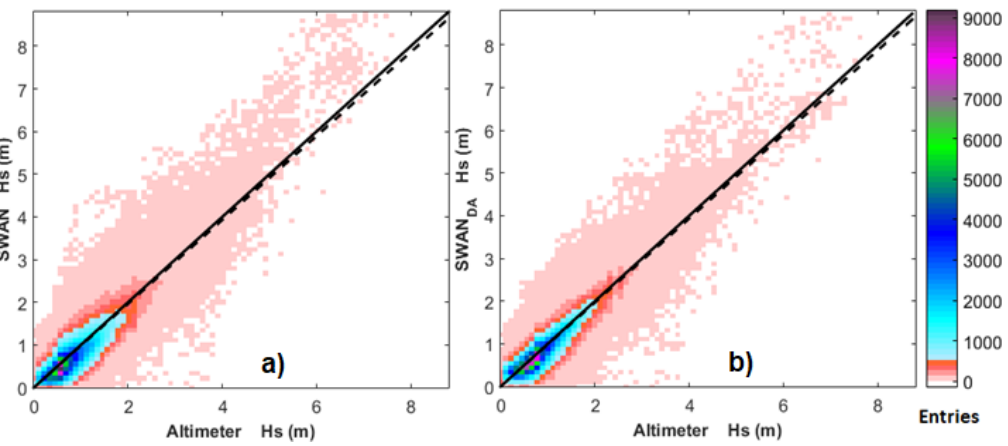
Figure 3. Hs s catter diagrams: a ) SWAN without DA and b ) SWAN with DA ( right ), results Figure 3. Hs scatter diagrams: a ) SWAN without DA and b ) SWAN with DA ( right ), results corresponding to the 15-year time interval 1999–2013. corresponding to the 15-year time interval